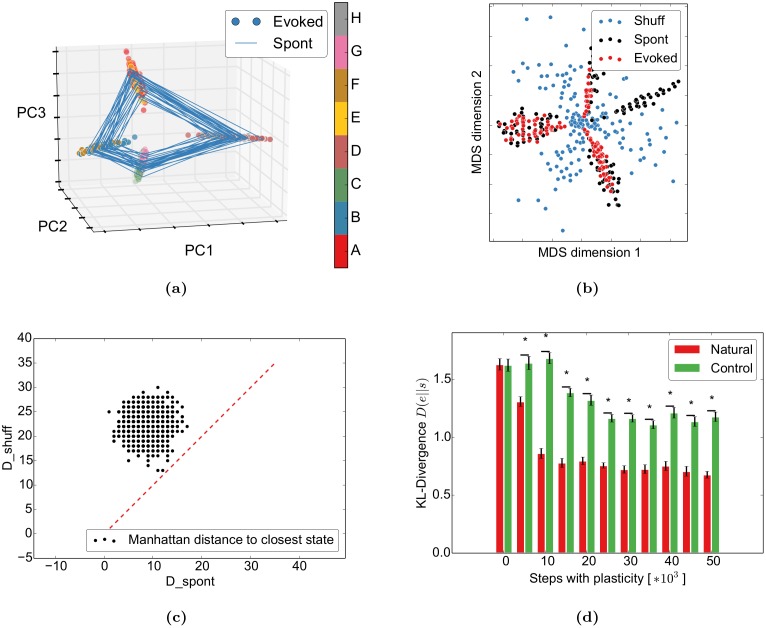
Spontaneous and evoked activity align through self-organization.The network was stimulated with the words “ABCD” (67%) and “EFGH” (33%). (a) The spontaneous activity follows the spatiotemporal trajectories of the evoked states in the PCA projection. (b) In the multidimensional scaling projection, the evoked activity (red) follows the spontaneous outline (black) and avoids the shuffled spontaneous states (blue) (cp. Fig 6c of [13]). (c) The evoked states are closer to the spontaneous states than to the shuffled spontaneous states: As in Fig 6 of [13], the distance from evoked states to the closest spontaneous states (D_spont) is smaller than the distance to the closest shuffled spontaneous state (D_shuff). The red dashed line shows equality. (d) Spontaneous activity becomes more similar to evoked activity during learning: After self-organizing to “ABCD” and “EFGH” with identical probabilities, spontaneous activity was compared to the evoked activity from the imprinted sequences (natural) or the two control sequences “EDCBA” and “FGH” (control) with Kullback-Leibler divergence. New networks were generated for each training time and condition. Error bars represent SEM over 50 independent realizations. ⋆ indicates p < 0.05 for a t-test assuming independent samples and identical variances.